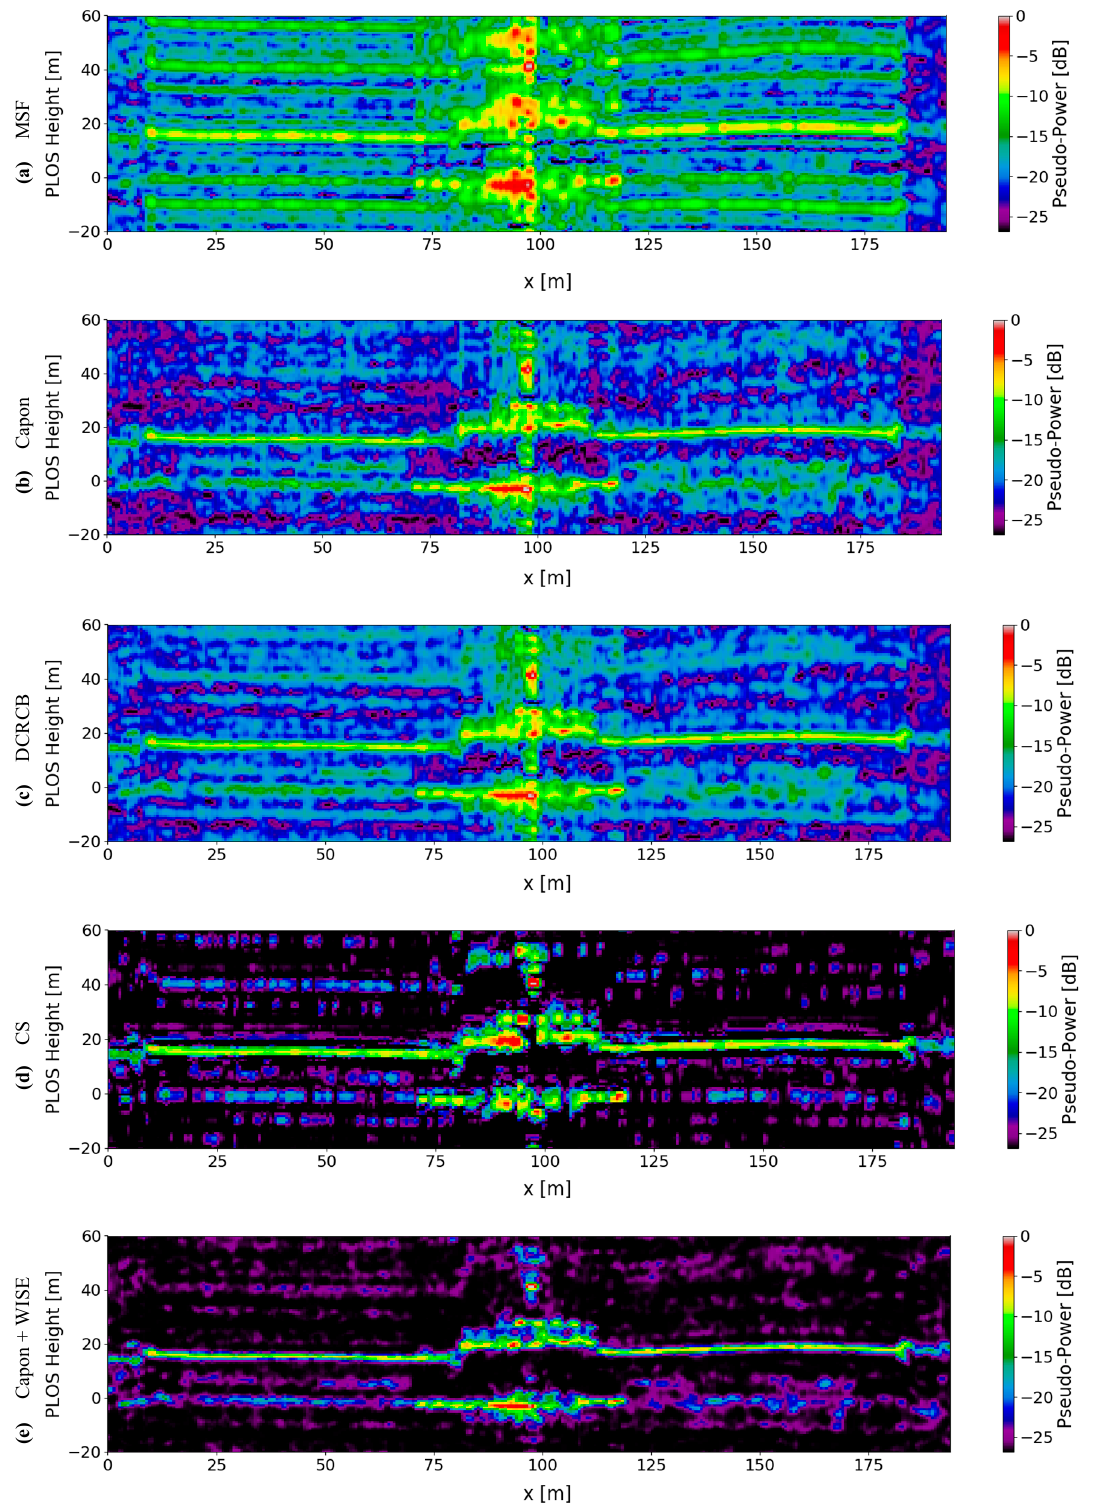
Figure 7. HH tomograms retrieved from the area depicted by the red line crossing the ROI specified in Figure 5. We perform focusing using ( a ) MSF, ( b ) Capon, ( c ) DCRCB, ( d ) CS and ( e ) Capon + WISE. A 15 × 3 (range/azimuth) pixel window is employed to perform multilooking via Boxcar filtering. All tomograms are normalized with respect to the (pseudo) power recovered by MSF.